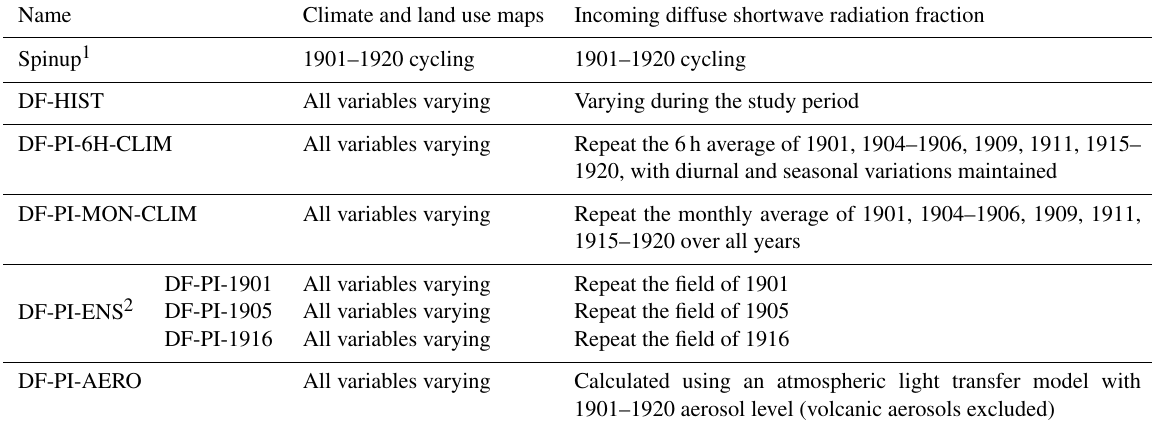
Table 1. Experimental design in this study.